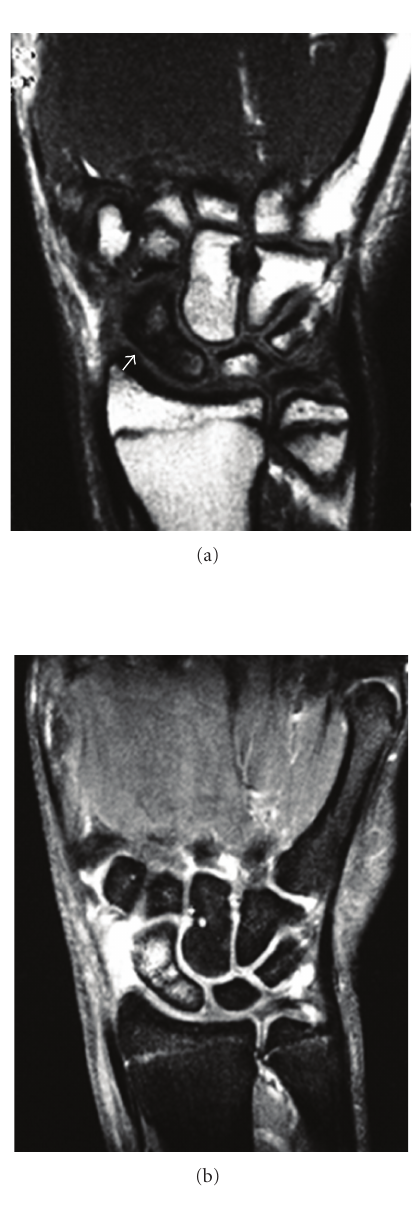
Figure 2: (a) T1-weighted coronal magnetic resonance image showing incomplete fracture at the waist of the scaphoid (white arrow); (b) T2-weighted coronal magnetic resonance image show- ing bone edema of the proximal and distal